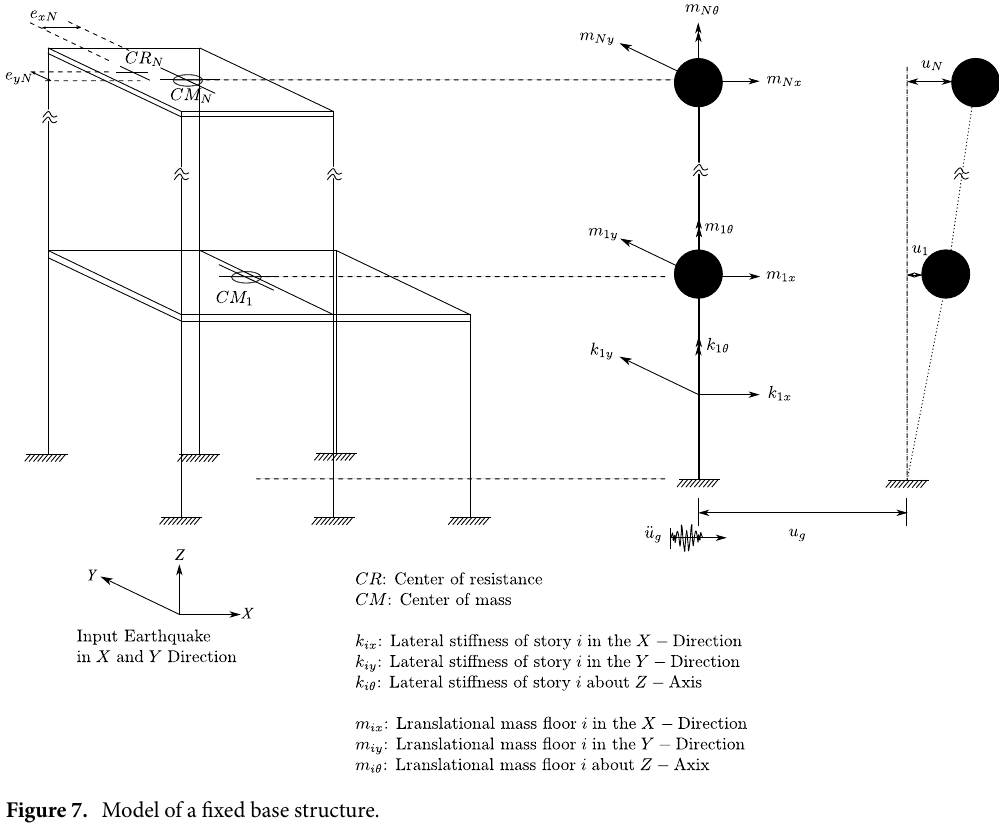
Figure 7. Model of a fixed base